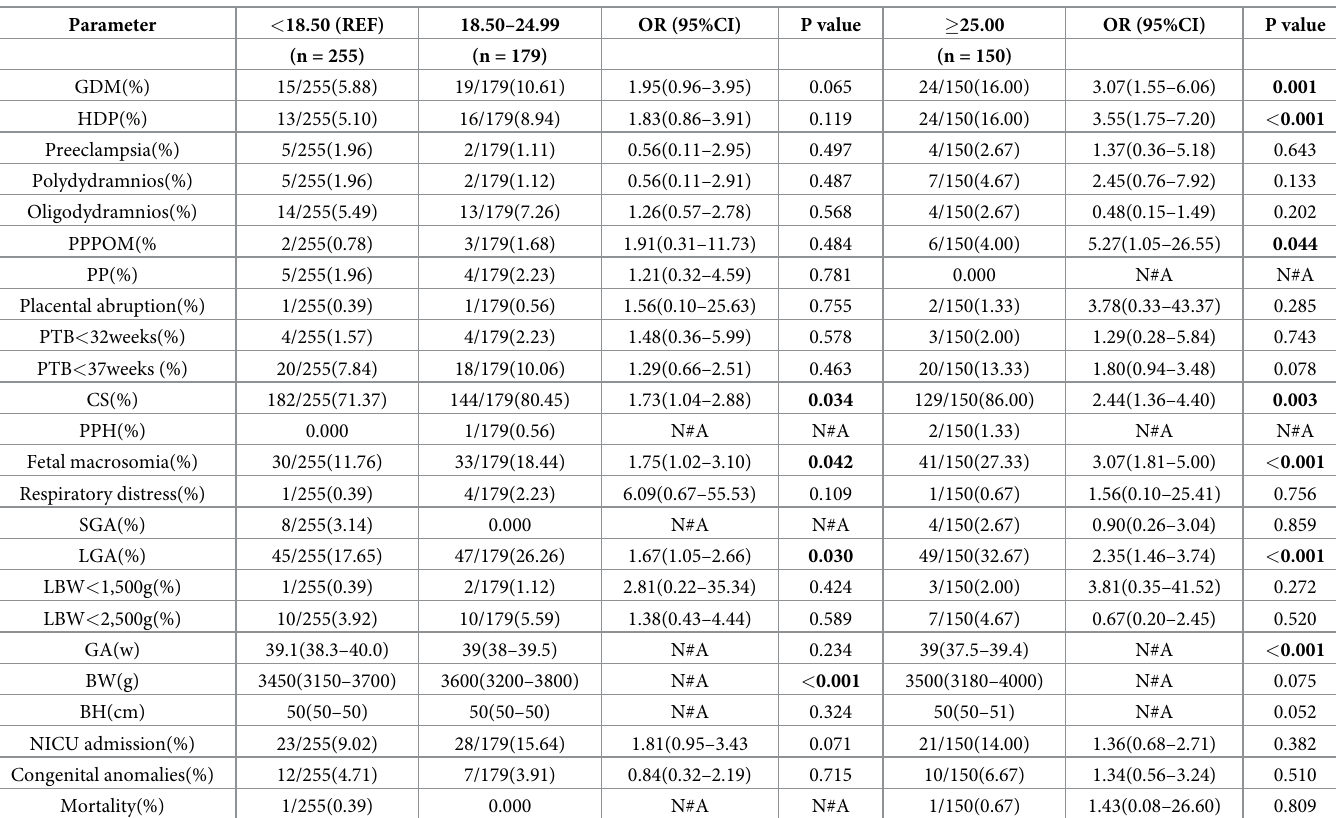
Table 6. Obstetric and neonatal outcomes by BMI category in women with PCOS.